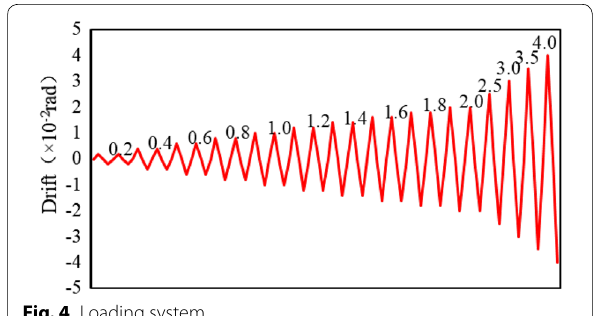
Fig. 4 Loading system.